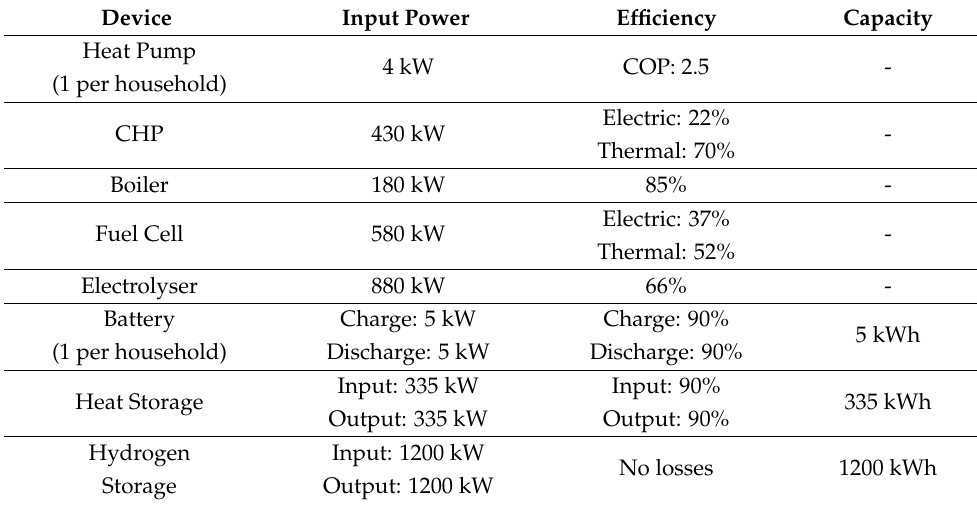
Table 1. The parameters of all devices considered by the